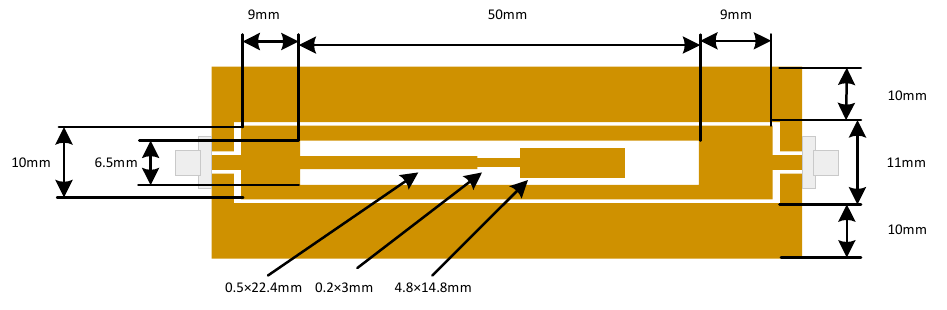
Figure 3. SIR circuit used in this work.